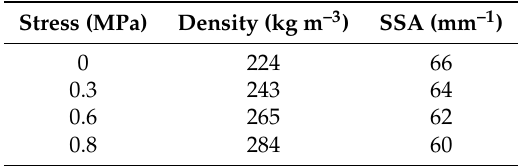
Table 1. Microstructural parameters under loading